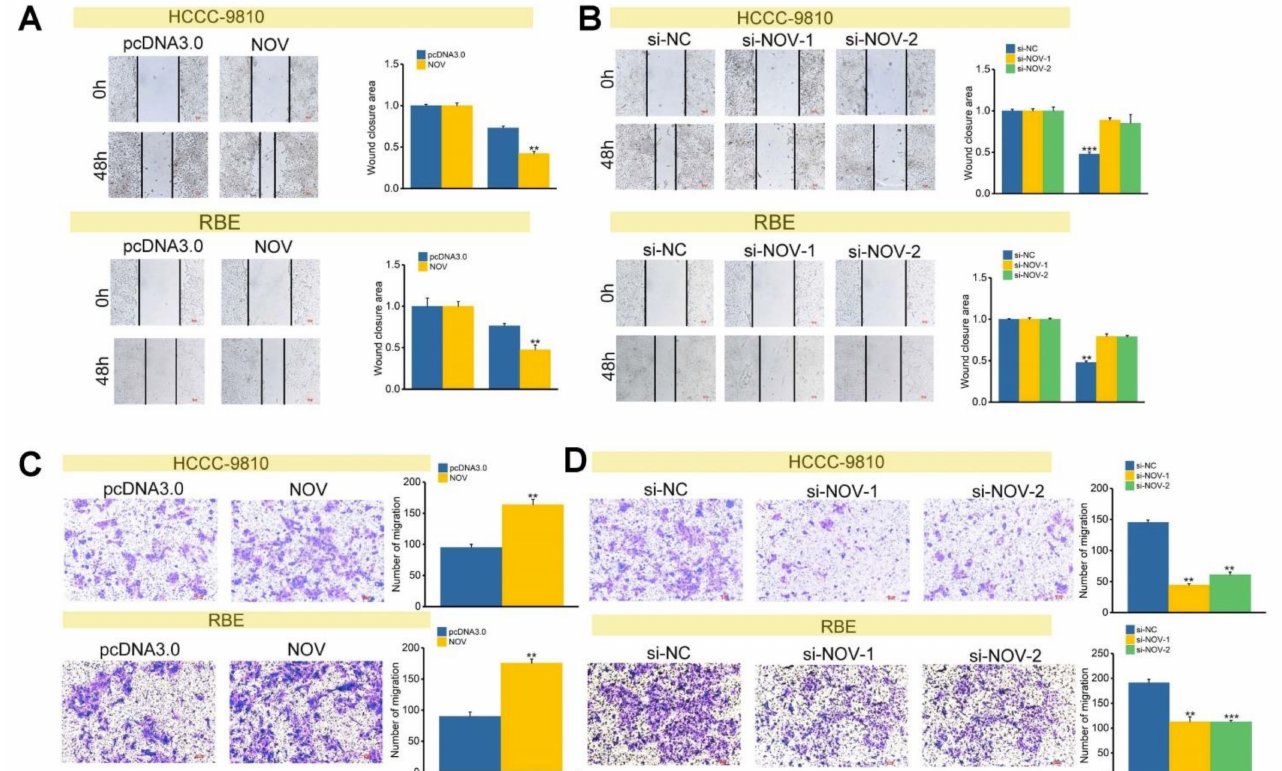
Figure 5. NOV promotes the migration of ICC cells. ( A ) The effect of NOV overexpression on cell migration via wound healing assay. ( B ) The effect of NOV silencing on cell migration via wound-healing assay. ( C ) The effect of NOV overex- pression on cell migration via transwell migration (100 × ). ( D ) The effect of NOV silencing on cell migration via transwell migration (100 × ). ** indicates p < 0.01 and *** indicates p <